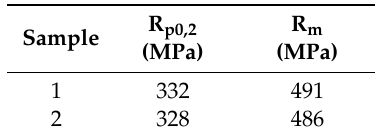
Figure 4. Tensile test: ( a ) test specimen and ( b ) tensile diagram. Table 1. Mechanical properties of the